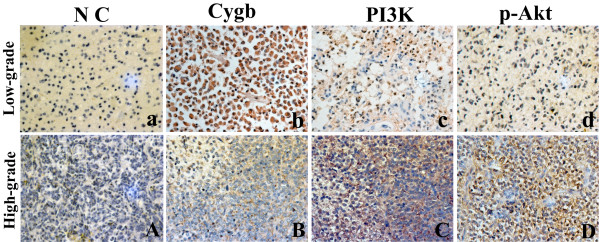
Immunohistochemical staining of Cygb, PI3K and p-Akt in low and high grade of glioma tissues. Negative control (NC) of low (a) and high (A) grade gliomas showed no positive staining cells. Strong and diffused expression of Cygb was found in low-grade gliomas (b); in high-grade gliomas, positive staining of Cygb was shown focally and weakly (B). Low-grade gliomas showed low expression of PI3K (c) and p-Akt (d) positive tumor cells in serial section. High expression of PI3K (C) and p-Akt (D) was shown in high-grade gliomas. (magnification: ×400).